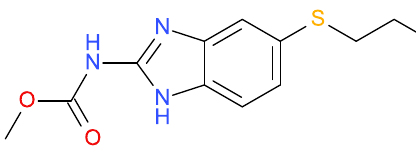
Figure 1. Chemical structure of ALZ. Earlier studies of ALZ ASDs did not recognize the occurrence of LLPS during dissolu- tion. In this study, the LLPS behavior of supersaturated ALZ solutions was investigated, and then an oral administration study of the ASDs was conducted in rats and dogs to observe the relevance of LLPS behavior to oral